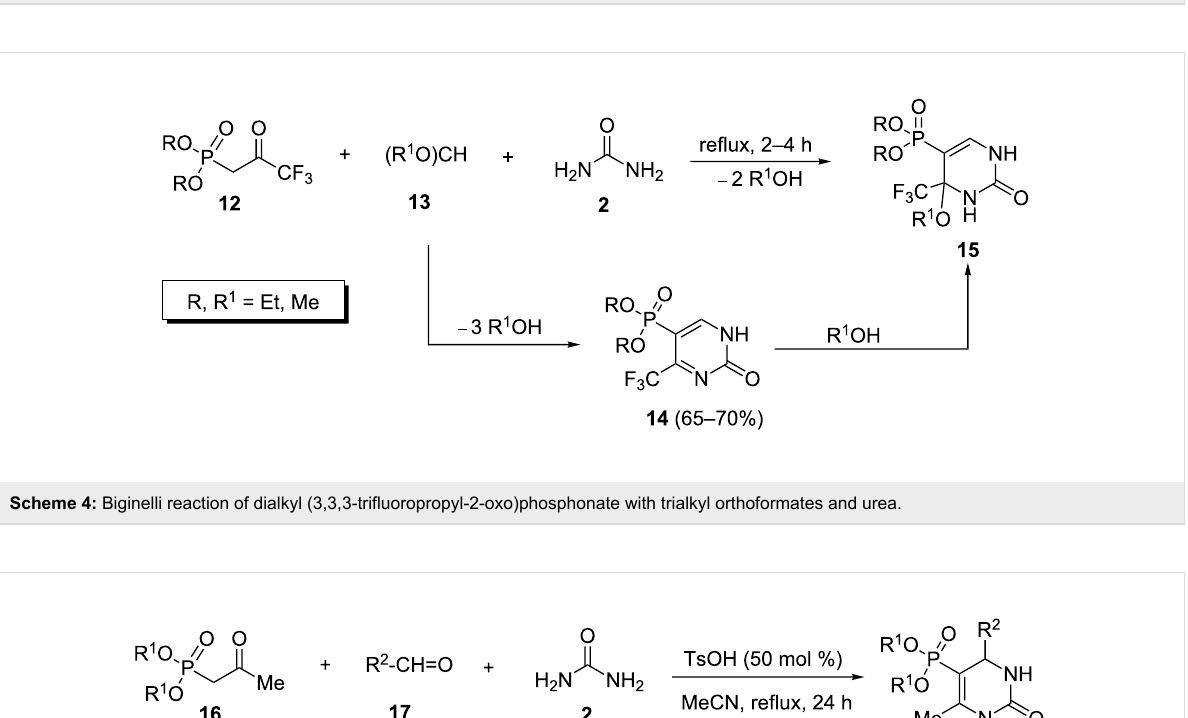
Scheme 3: Trimethylchlorosilane-mediated Biginelli reaction of diethyl (3,3,3-trifluoropropyl-2-oxo)phosphonate.